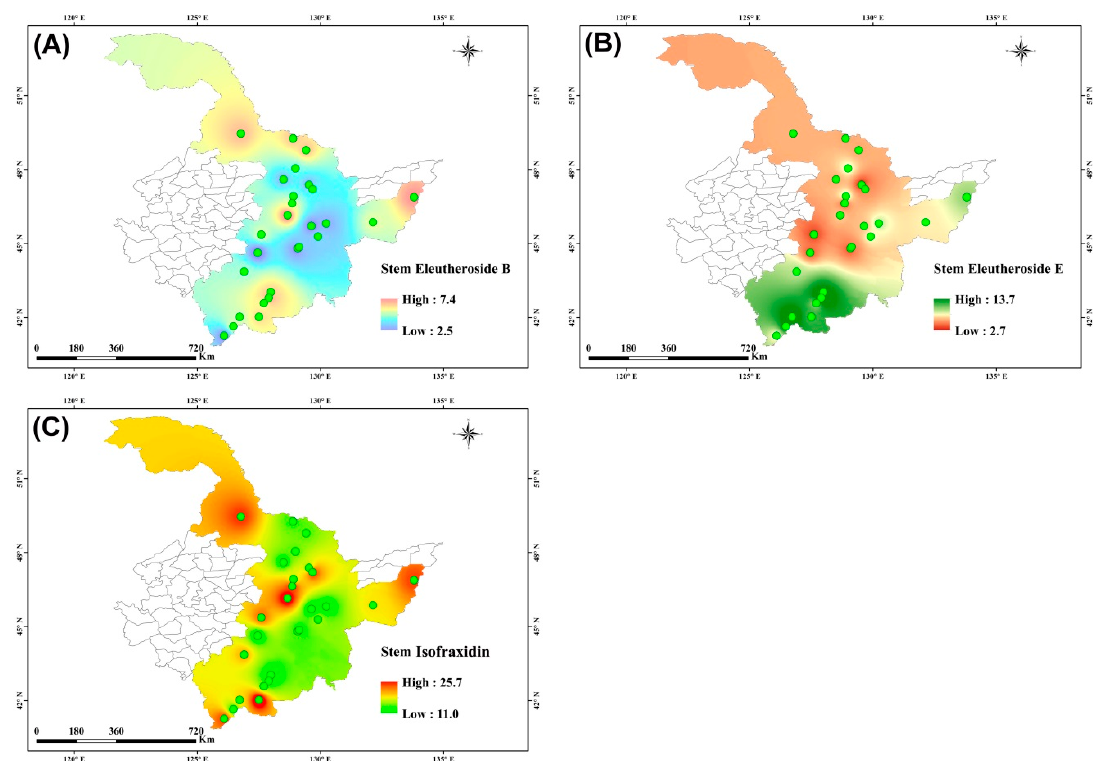
Figure 4. Interpolated mapping of geographical distributions of concentrations of bioactive compounds in aerial organs of Eleutherococcus senticosus individuals from populations in Northeast China. ( A ) Geographical distribution of eleutheroside B (mg g − 1 ); ( B ) geographical distribution of eleutheroside E (mg g − 1 ); ( C ) geographical distribution of Isofraxidin (mg g − 1 ). Green dots indicate distribution of plots.